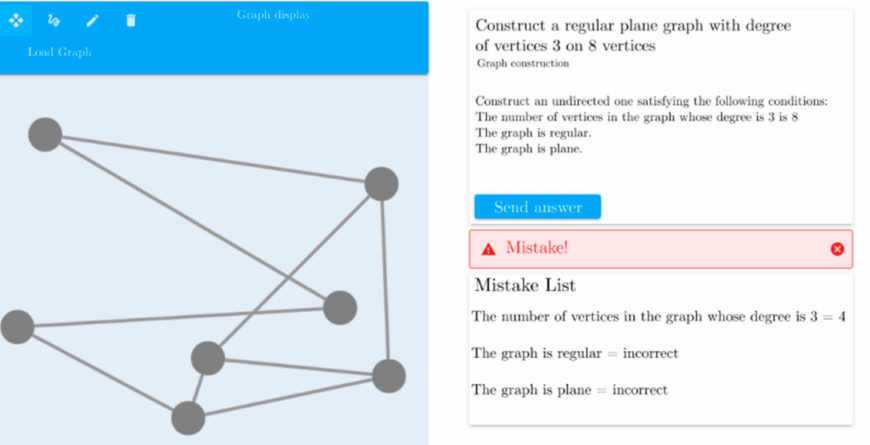
Figure 4. An example of an incorrect solution to the problem and the reaction of the system to errors (the figure is taken from [43]).